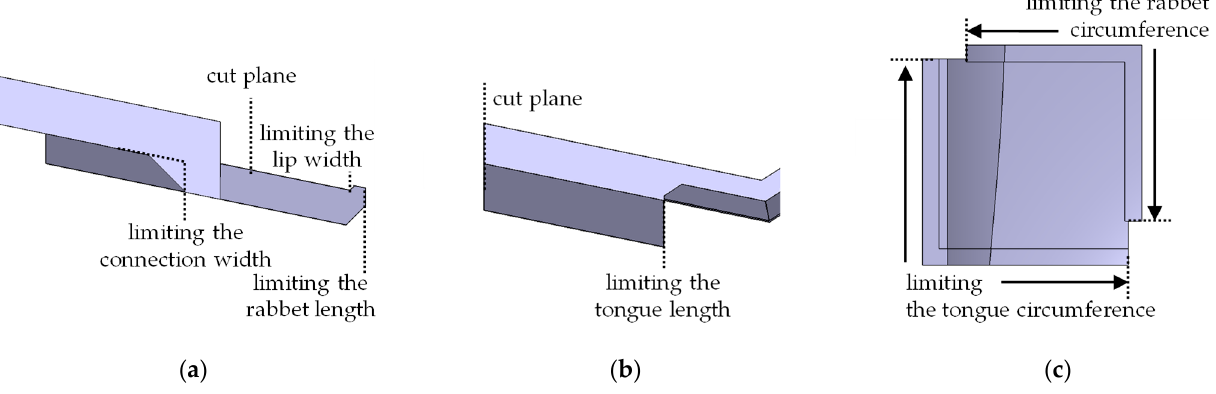
Figure 13. ( a )Areas of the rabbet formed by boundary planes; ( b ) Areas of the tongue formed by boundary planes; ( c ) Boundary planes limiting the circumference After deriving the shells of rabbet and tongue from trimming the surface offsets with the boundary planes, the shells are filled and joined to the cutout of the segment (Figure 14b). Chamfers are used to avoid overhangs and cross-sectional jumps in the area of force transmission. The chamfering takes place at the transitions of the rabbet and the tongue toward the segment, along the leading edge of the rabbet and in the inner edge of the lip (Figure 14a). Now, the segment has all geometric elements required for the joggle lap. ( a )